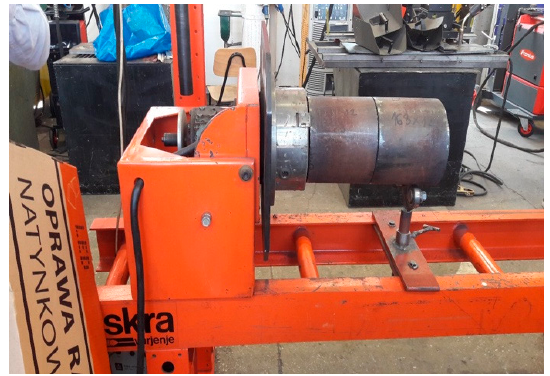
Figure 1. Pipes prepared for welding.